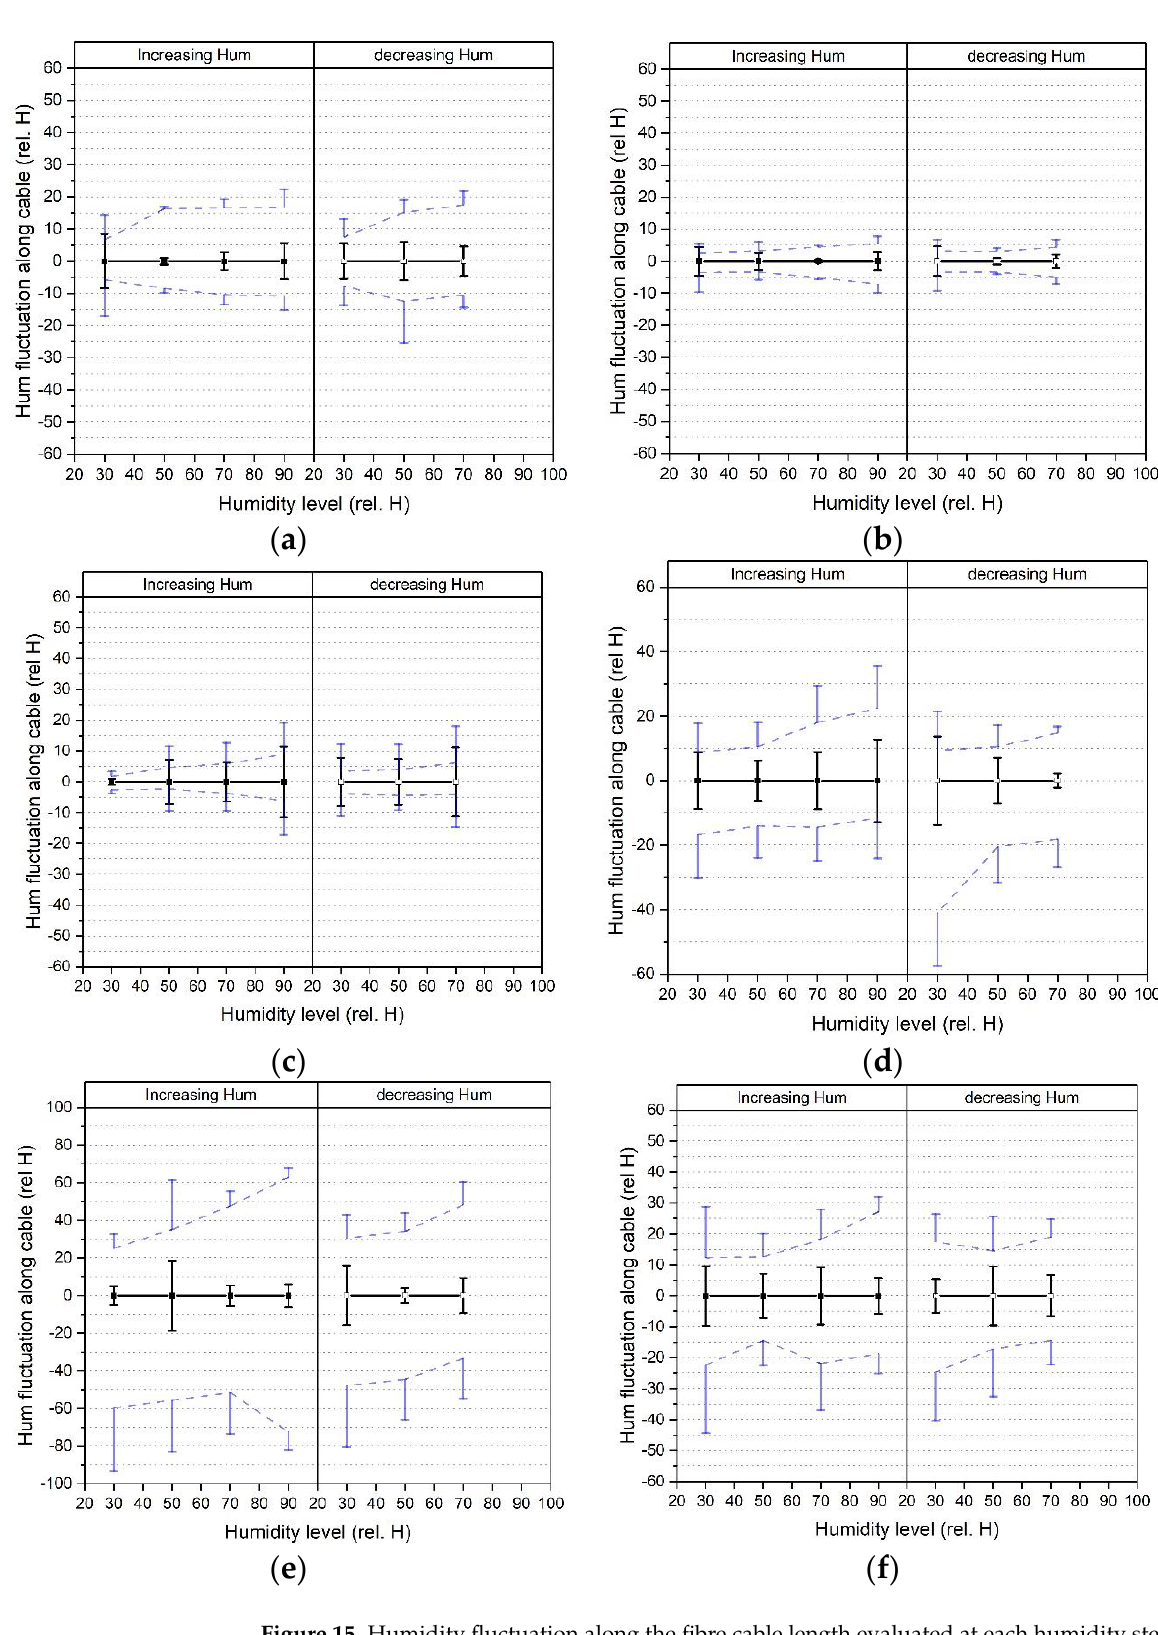
Figure 15. Humidity fluctuation along the fibre cable length evaluated at each humidity step for the increasing step ( left column ) and decreasing step ( right column ) for ( a ) bare fibre, ( b ) 900 μm tight buffered, ( c ) 2.0 mm tight buffered, ( d ) 3.2 mm ribbed tight buffered, ( e ) 3.8 mm gel filled loose tube and ( f ) 3.0 mm air filled loose tube cable.